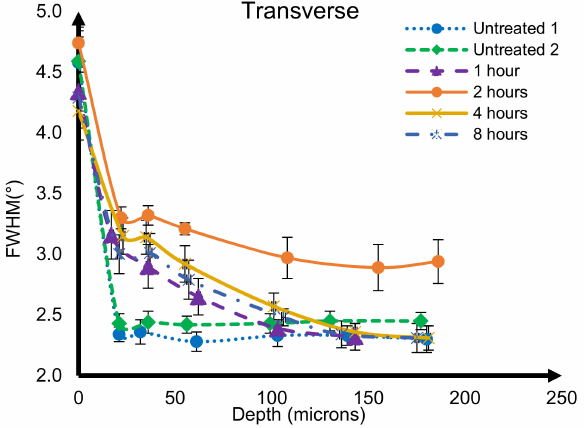
Figure 11. Full-width at half-maximum (FWHM) distribution of IN718 at − 130 mm in the transverse